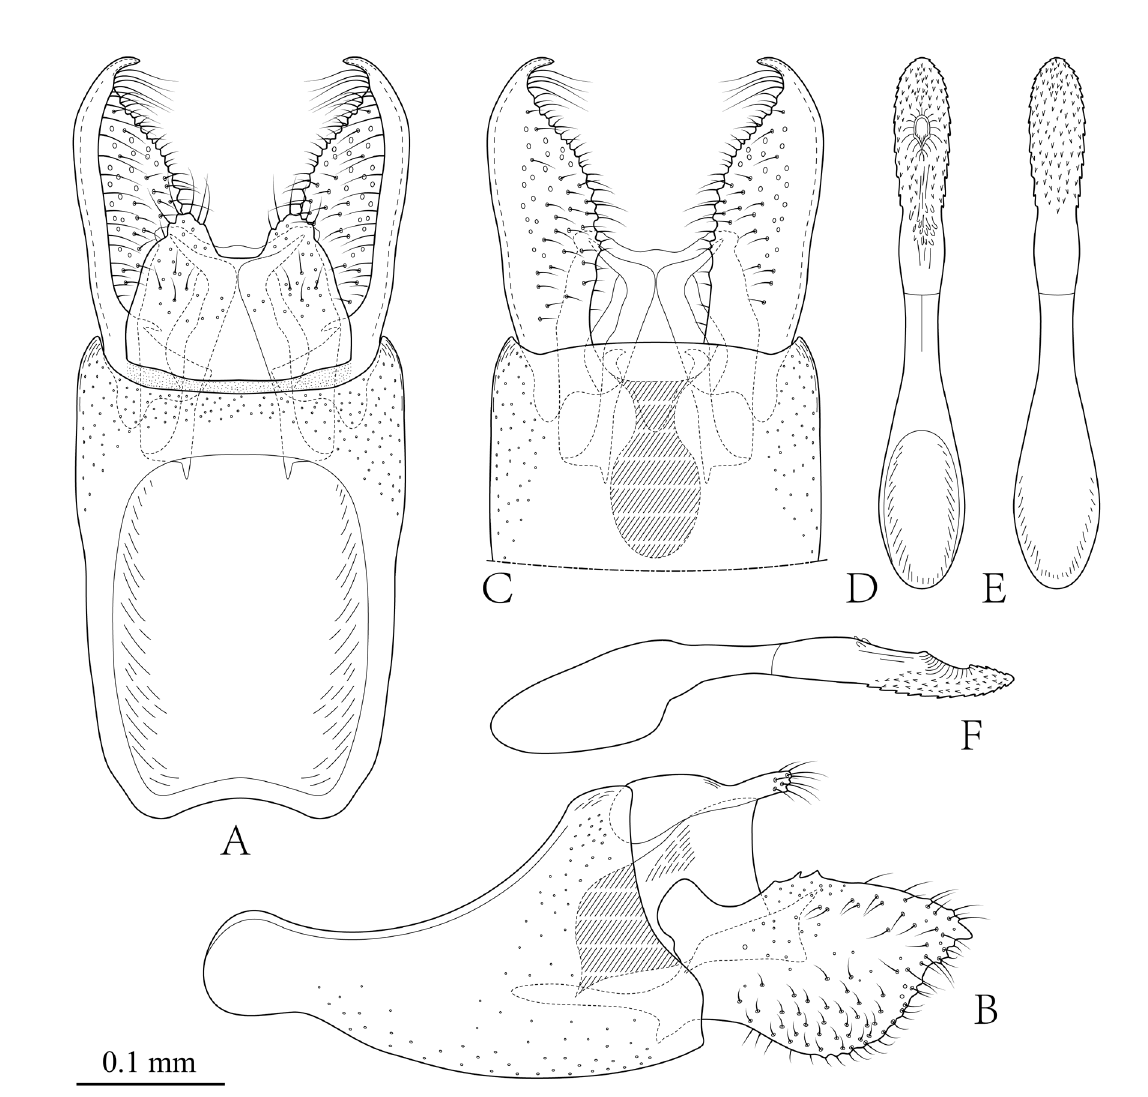
Fig. 3. Male genitalia of Vietomartyria wuyunjiena sp. nov. A . Dorsal view, with phallus removed. B . Ditto , ventral view. C . Ditto , lateral view. D . Phallus, dorsal view. E . Ditto , ventral view. F . Ditto , lateral